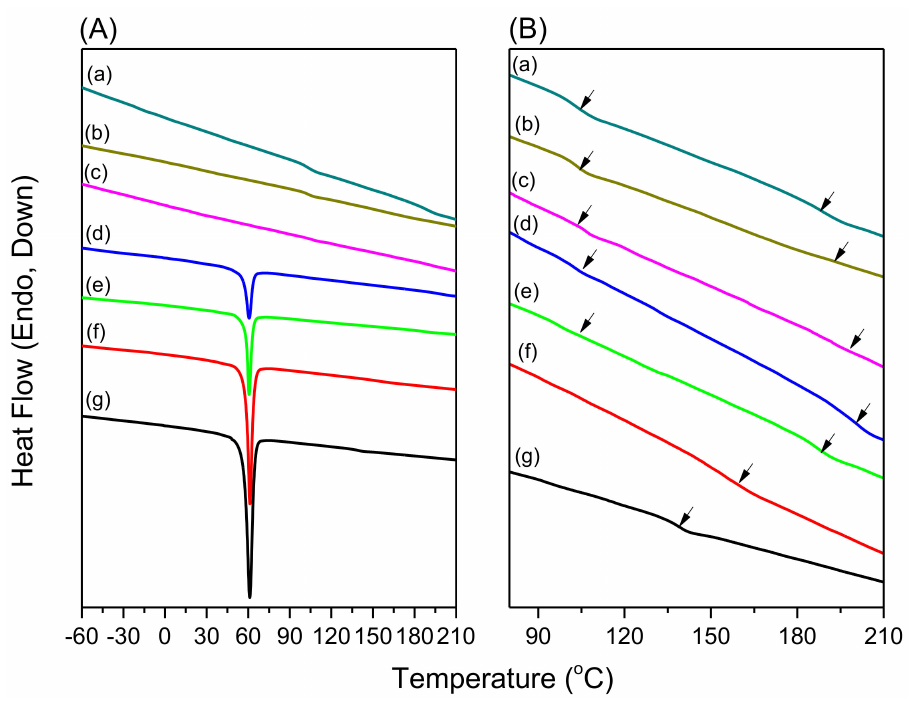
Figure 5. DSC analyses of PS- b -PVPh/PEO- b -P4VP mixtures of range from ( A ) − 60~210 ◦ C, and ( B ) 80~210 ◦ C for (a) 100/0, (b) 90/10, (c) 70/30, (d) 50/50, (e) 30/70, (f) 10/90, and (g)